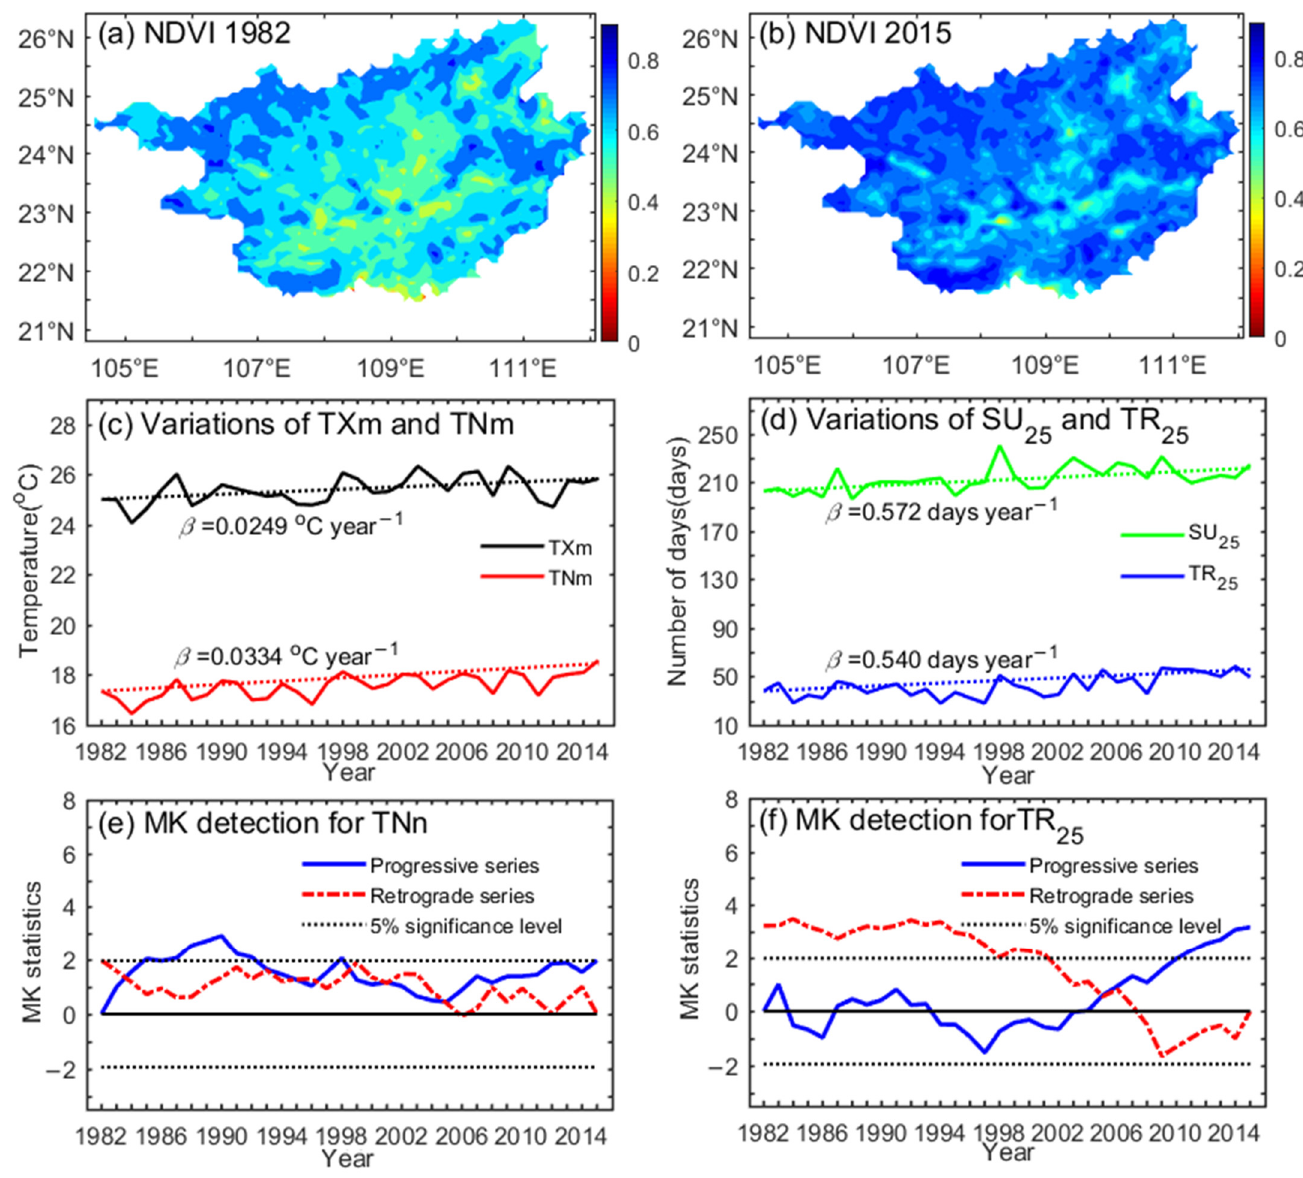
Figure 9. Spatial distributions of the annual NDVI in 1982 ( a ); spatial distributions of the annual NDVI in 2015 ( b ); inter-annual variations of TXm and TNm ( c ); inter-annual variations of SU 25 and TR 25 ( e ); the Mann–Kendall (MK) abrupt change detection for TNn ( e ); and the Mann–Kendall (MK) abrupt change detection for TR 25 ( f ). Note: in ( c , d ), the solid line represents the observed data, and the dotted line represents the fitted data.